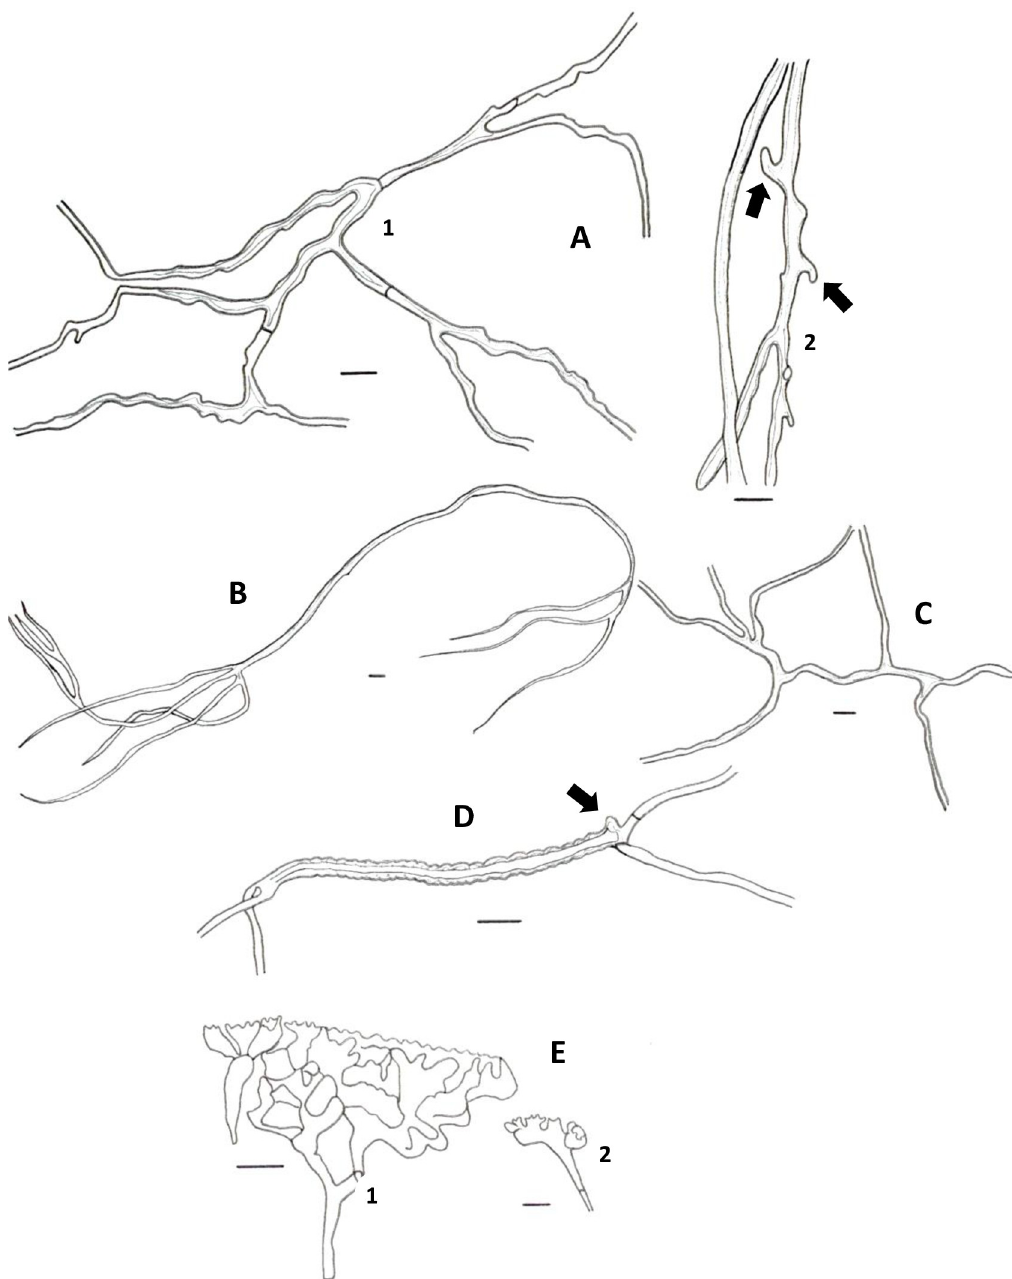
Fig 13. Microscopical features from context, stipe and rhizomorphs of P . leprieurii var. yasuniensis . A. Skeletal-binding hyphae from context, 1 Thick-walled sections and 2 Hooked-like sections of hyphae (arrows pointing to hooked sections). B. Skeletal-binding hyphae from rhizomorphs. C. Skeletal-binding hyphae from stipe D. Plectenchymatous thickenings from rhizomorphs (arrow pointing to a clamp connection). E. Melanized cuticle cells from stipe, 1 Palisade layer of cells and 2 Individual cuticle cell. Scale bars = 10 μ